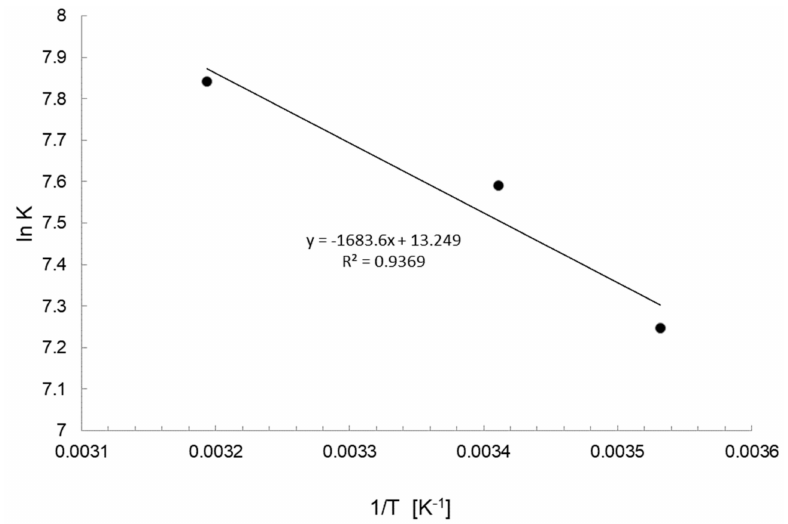
Figure 9. Van’t Ho ff plot of zinc (Zn) sorption on the biomass based activated carbon.